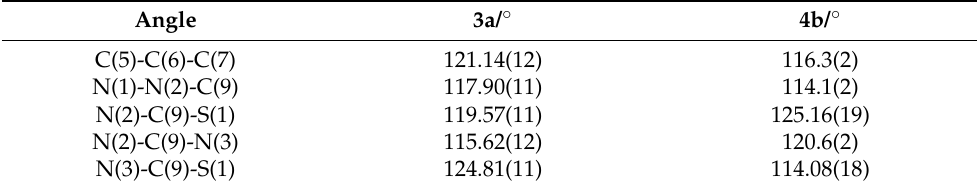
Table 2. Comparison between angles in compounds 3a and 4b .